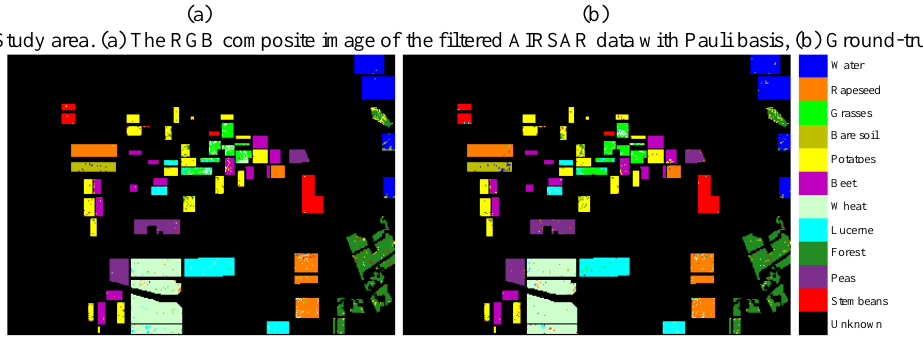
Figure 2 Study area. (a) The RGB composite image of the filtered AIRSAR data with Pauli basis, (b) Ground-truth map